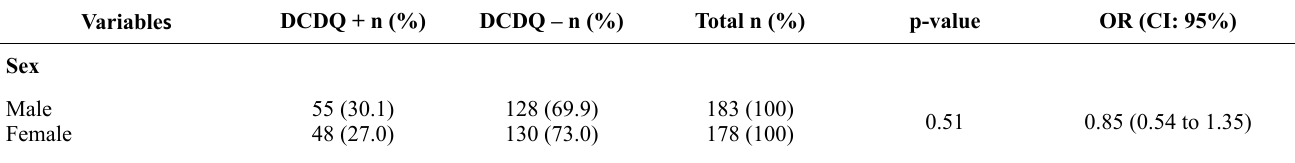
Table 2 - Positive or negative characterization of children based on the DCDQ classification Variable